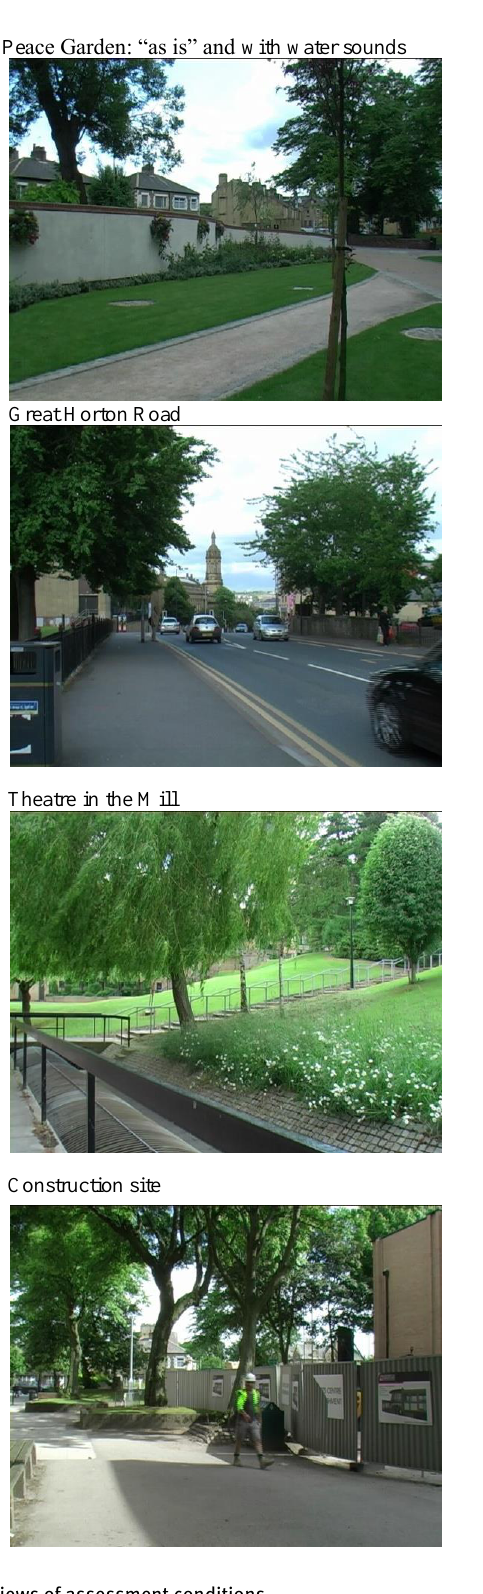
Figure 4: Views of assessment